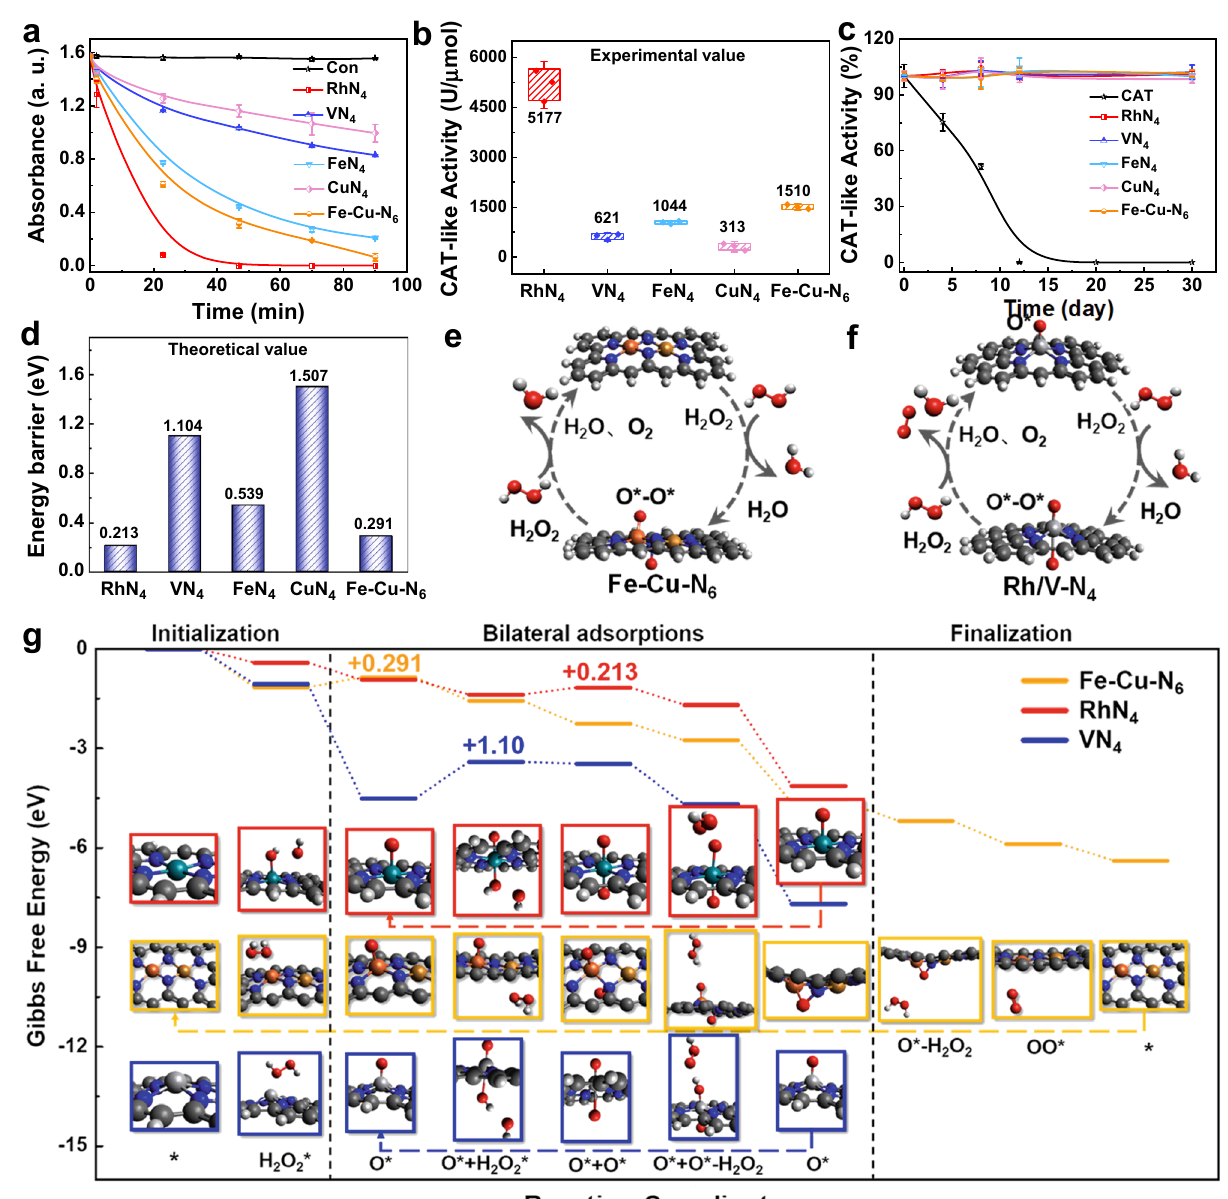
Fig.4|TheCAT-likeactivityofMN x .a Reaction-timecurvesofthedecomposition ofH 2 O 2 catalyzedby4.8 μ MMN x ( n =3independentexperiments). ‘ a.u. ’ represents arbitrary units. b Quanti fi cation of speci fi c CAT-like activities of MN x . One enzyme activity unit represents the amount of MN x that catalyzes the decomposition of 1 μ mol H 2 O 2 within 1minute ( n =3 independent experiments; boxes represent the medianandIQR andtheupperand lowerwhiskersextending to thevalues that are within 1.5×IQR). c Comparison of the stability of CAT-like activities between MN x and natural enzymes ( n =3 independent experiments). d The energy barriers of